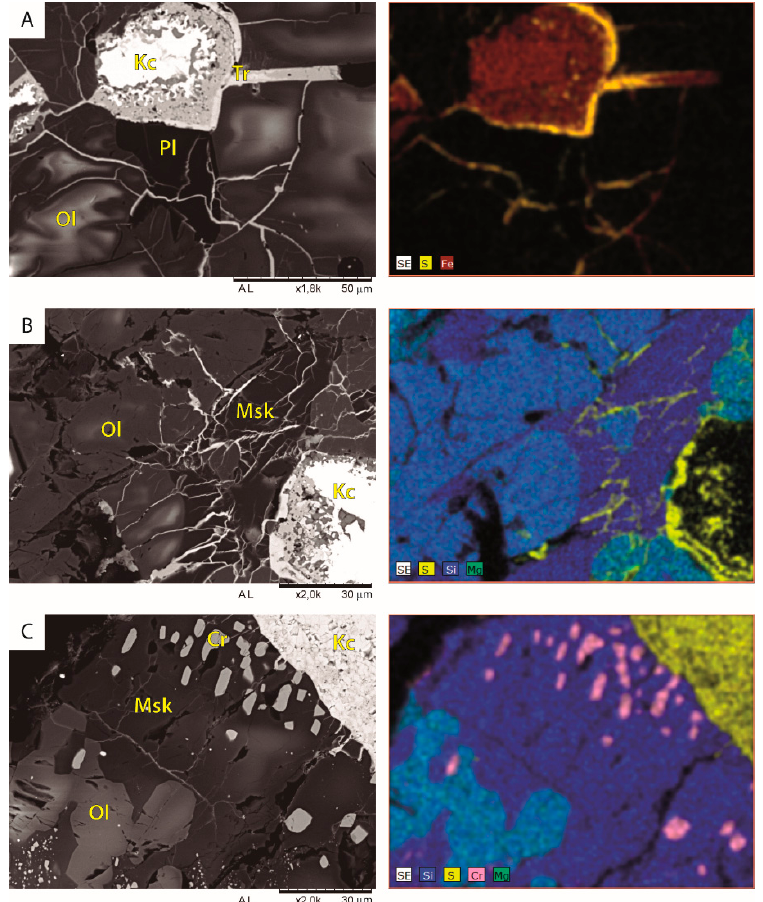
Figure 12. Scanning Electron Microscope images (left) and composition maps (right). ( A ) Sulfurous veins surrounding a taenite-kamacite grain. ( B ) Sulfurous veins filling olivine grains, and transformation of taenite-kamacite grains into troilite-pentlandite. ( C ) Chromite formation by Cr-di ff usion from olivine and Fe-alteration of kamacite. Msk: Maskelynite; Ol: Olivine; Tr: Troilite; Kc: Kamacite; Pl: Plagioclase; Cr: Chromite.